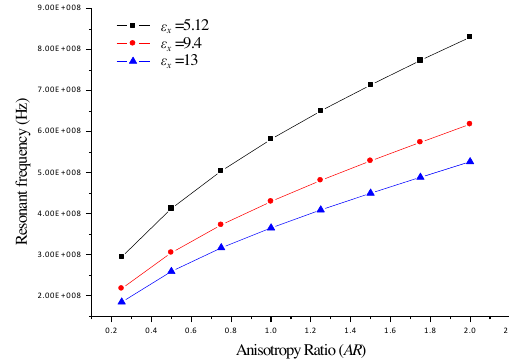
=35mm , r /r =2 , 2 2 1 Figure 4: Resonant frequency versus anisotropy ratio ( AR ) for different permittivity d =1.59mm, and d 2